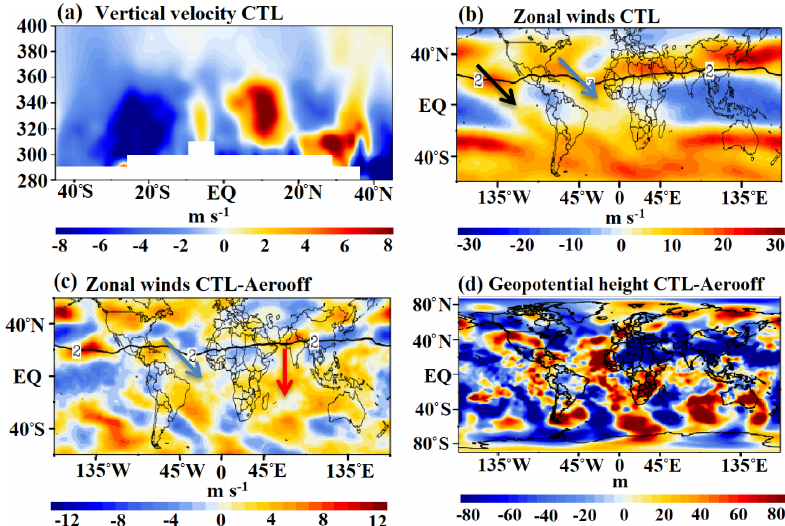
Figure 5. (a) Meridional cross-section of vertical velocities (ms − 1 ) (averaged for 65–140 ◦ E and for spring season during 2001–2016). Vertical velocities are scaled by 300. (b) Zonal winds at the 360K isentropic level from CTL simulations, where a black arrow indicates the Pacific duct, and a blue arrow indicates the Atlantic duct. (c) Anomalies (CTL-Aerooff) of zonal winds at the 360K isentropic level. A blue arrow indicates the Atlantic duct, and a red arrow indicates the duct over the Indian Ocean. (d) Anomalies (CTL-Aerooff) of geopotential height (m) at the 340K potential temperature level. The potential vorticity (2PV) is indicated by the black contour in b–c .